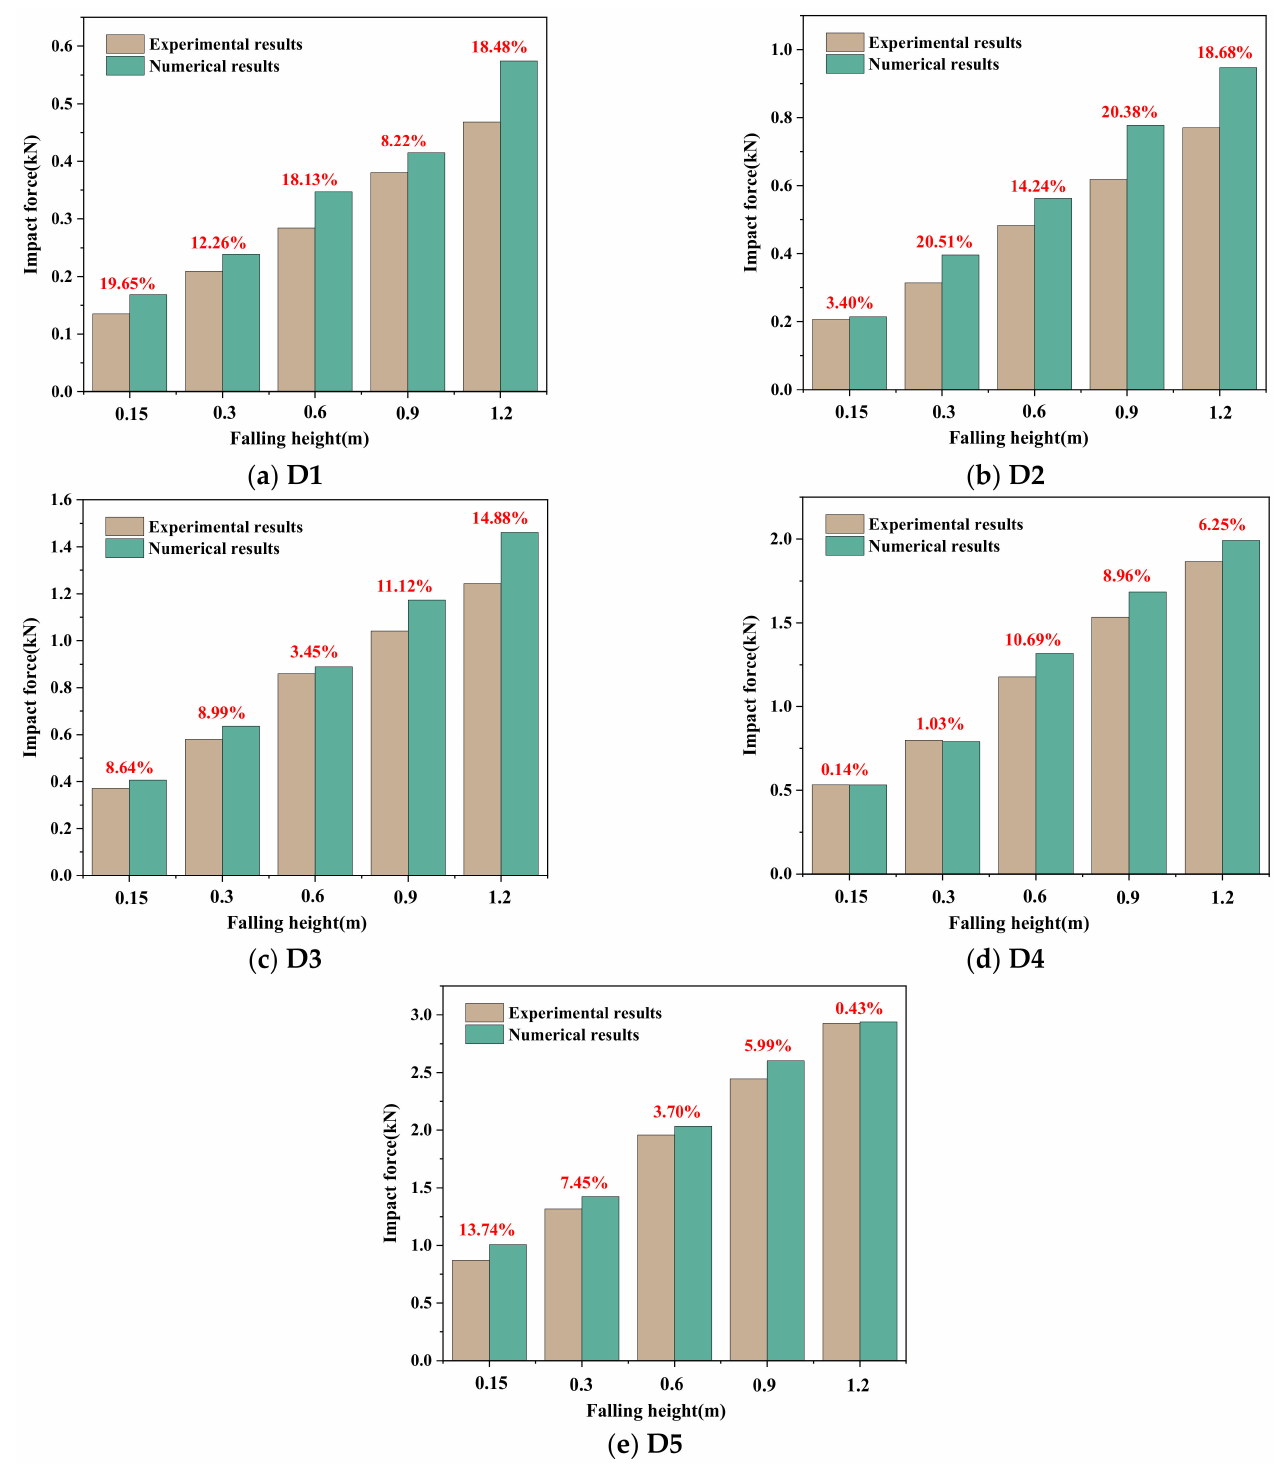
Figure 9. Comparison of the experimental results and numerical results of five shapes of falling rocks at five falling heights. ( a – e ) correspond to five different shapes of rockfall,